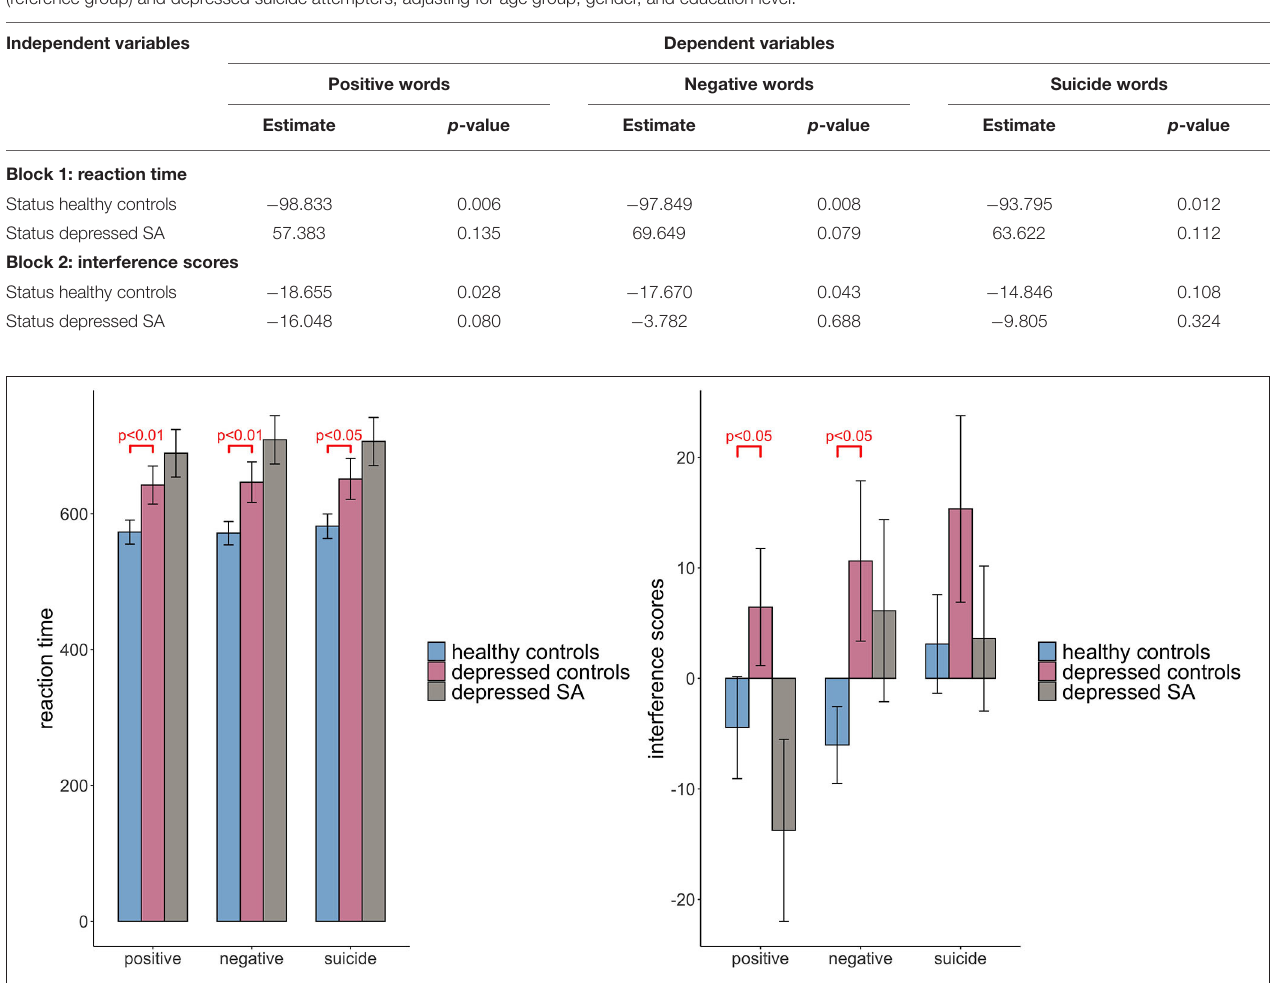
TABLE 3 | Parameter estimates in the linear regression models comparing reaction time and interference scores among healthy controls, depressed non-attempters (reference group) and depressed suicide attempters, adjusting for age group, gender, and education level. Independent variables